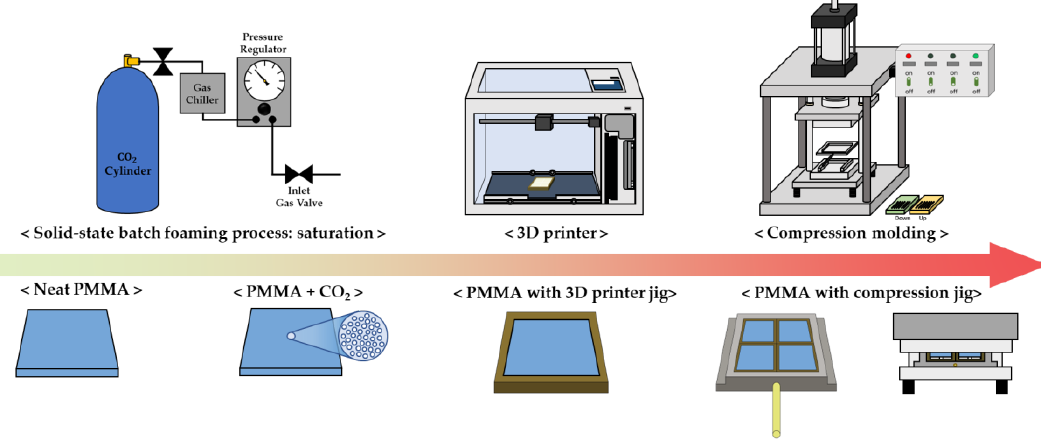
Figure 4. Schematic of jig for compression molding.